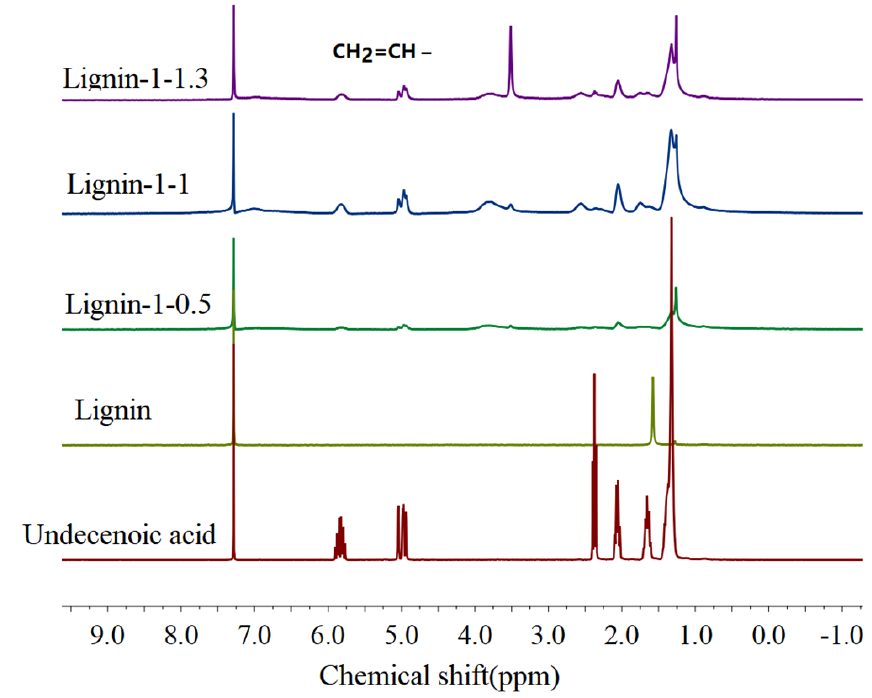
Figure 3. 1 H NMR of OFL, lignin and undecenoic acid.